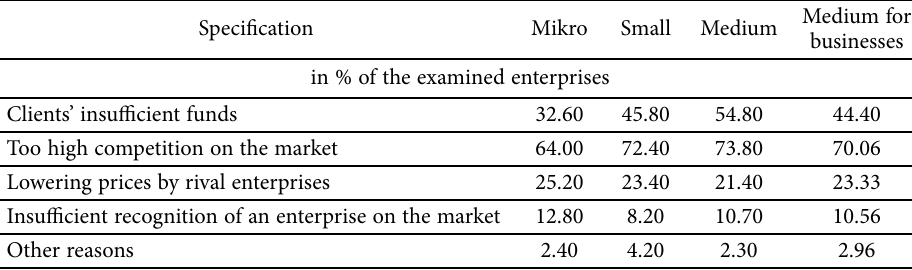
Medium for businesses